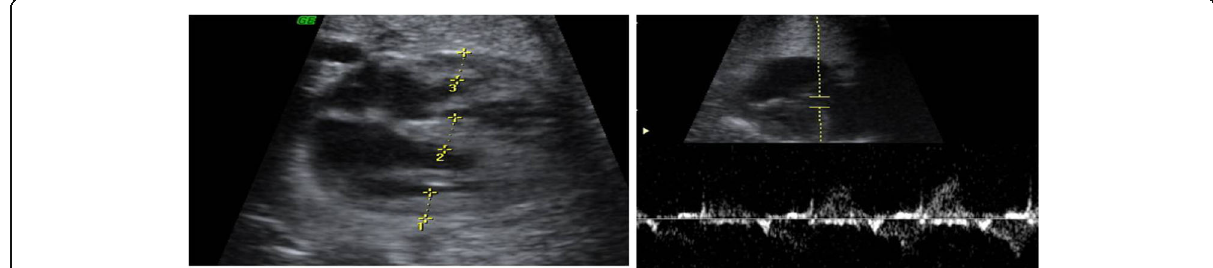
Fig. 6 2D measurement of myocardial and septal wall thickness in lateral 4 chamber view and Doppler derived measurement of left modified myocardial performance index in a pregnant female 25 years, with history of type I diabetes on regular insulin therapy came for routine antenatal ultrasound at 30 weeks gestation. Abnormal increase in myocardial and septal wall thickness with abnormally high MPA above the reference values (RVWT = 0.81, LVWT = 0.86, IVST = 1, Tie =